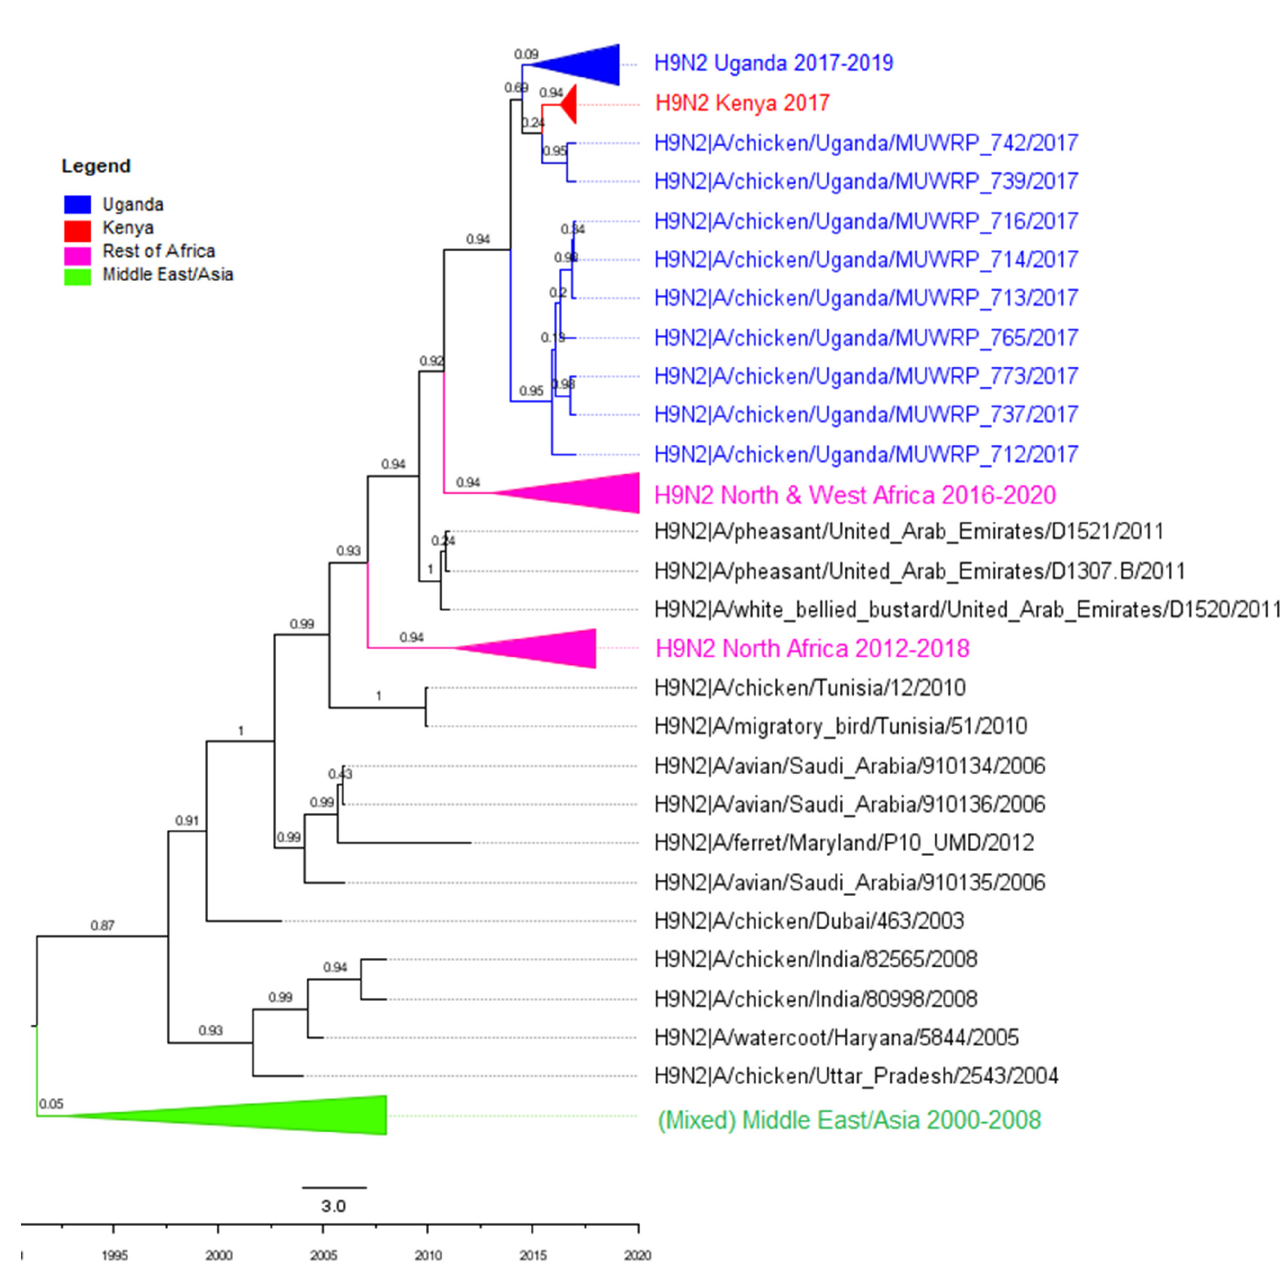
Figure A4. Phylogenetic tree for NP. Ugandan viruses are highlighted in blue, Kenyan in red, North and West African countries in pink, and the Middle East and Asia in the green clade. tMRCA for Uganda is December 2013. Posterior probabilities are shown on the branches. Scales represent substitutions and time.